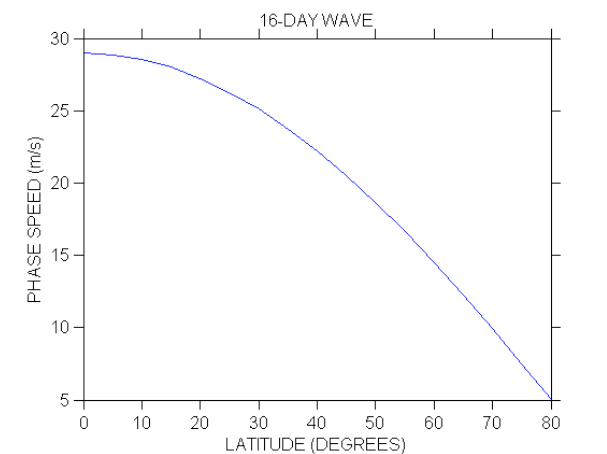
Fig. 1. Zonal phase speed as a function of latitude for a 16-day wave of zonal wavenumber